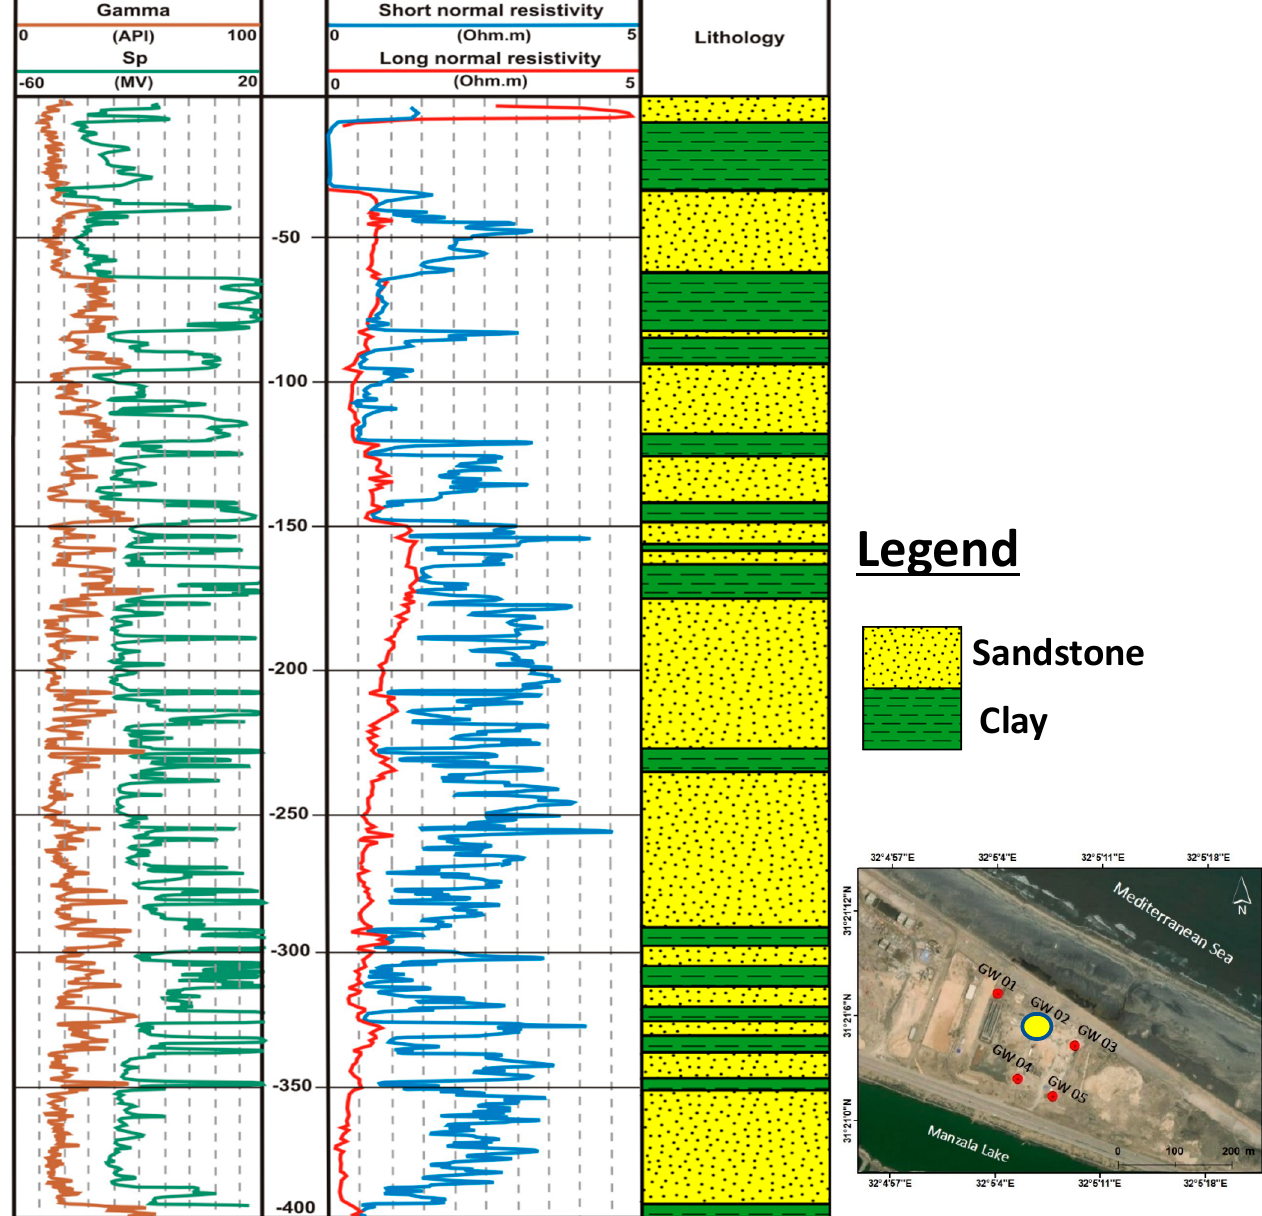
Figure 8. Gamma ray, SP, resistivity logs and the corresponding lithology in well GW02.